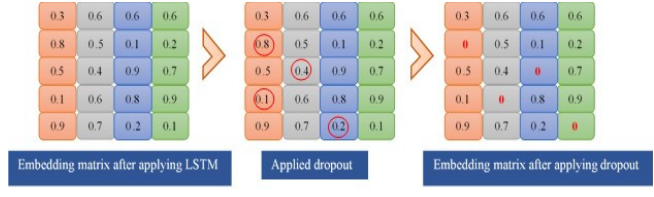
Figure 5. Using a dropout layer.